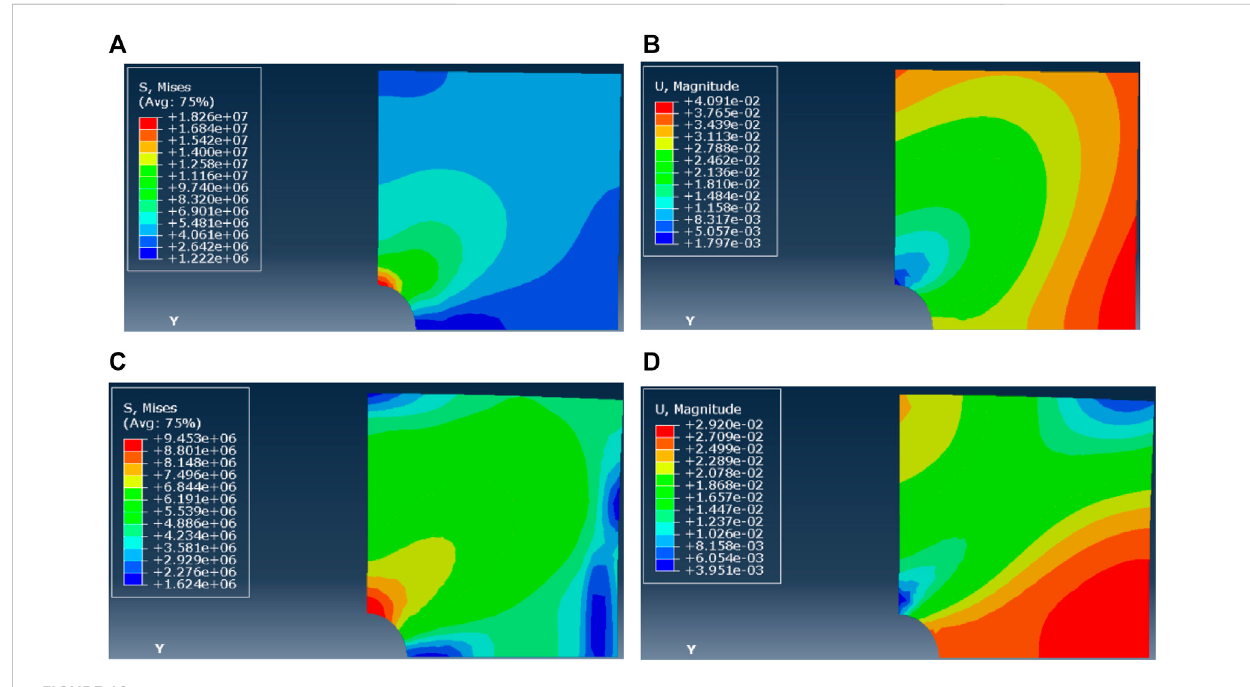
FIGURE 12 (A – D) Mises stress and displacement of borehole shrinkage after reaming ( Δ P = 5 MPa, n = 1). Mises stress and displacement of borehole shrinkage after reaming ( Δ P = 5 MPa, n = 5)